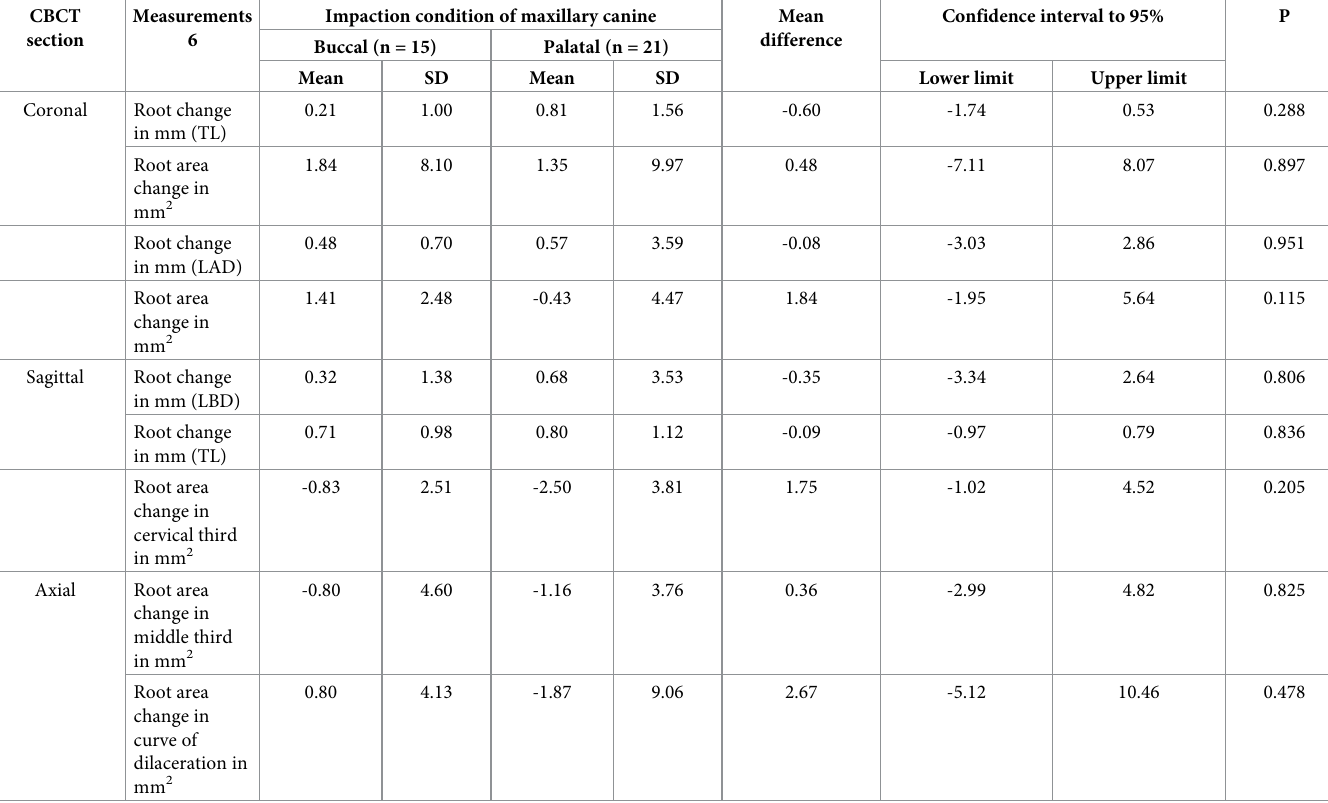
PAMIC, premolars adjacent to the maxillary impacted canine; MIC, maxillary impacted canine; LAD, length after dilaceration ; LBD, length before dilaceration ; TL, total length